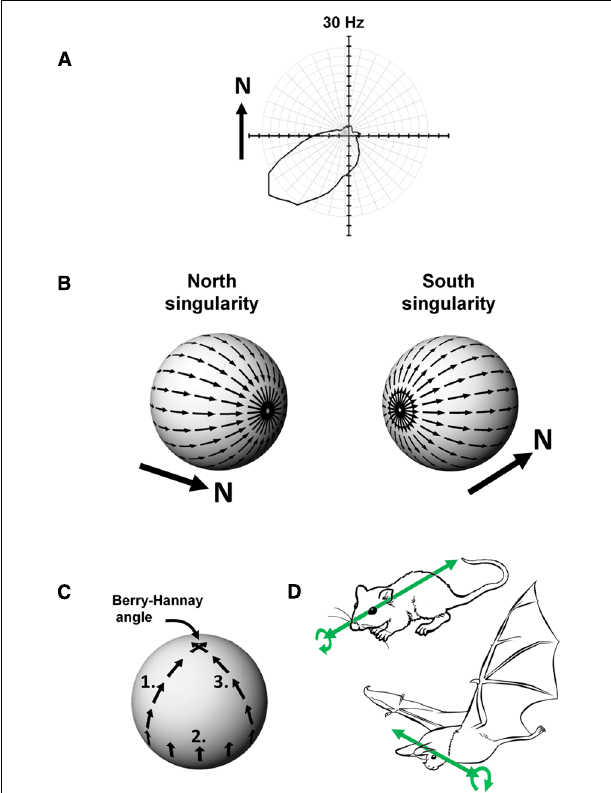
FIGURE 4 | (A) Firing of a head direction cell, expressed as a polar plot of head direction (in the Earth-horizontal plane) vs. firing rate, showing a preference for spiking when the animal faces South-West. (B) The Hairy Ball problem: it is not possible to coat the surface of a sphere with smoothly changing vectors because there are always two singularities. In this example, a “North”-indicating head direction cell would have to abruptly reverse its firing direction (with respect to the sphere) when the animal crosses the Northernmost or Southernmost poles of the sphere. (C) Acquisition of a rotational error, the Berry-Hannay angle, when a notional “North”-facing head direction cell is transported around the surface of a sphere. In this example, first the animal undergoes a pitch rotation in moving from the top of the sphere to the equator (1), followed by a roll rotation as the animal sidles (still facing upward) around the equator by 90° (2), and then another pitch rotation as the animal climbs back to the top of the sphere (3). Although the animal never made a yaw rotation at any stage, the head direction cell has rotated its preferred firing direction by 90° counter-clockwise. (D) Possible differences in directional reference frames between rats and bats. In rats, which roll a lot (curved arrow) but pitch rarely, the stable reference for head direction cells may be the antero-posterior axis (the long axis of the head; straight arrow). A given head direction cell will thus be unaffected by rolls. In bats, which pitch a lot but roll rarely, the stable reference may be the transverse axis (across the ears) with the head direction cell being unaffected by pitch